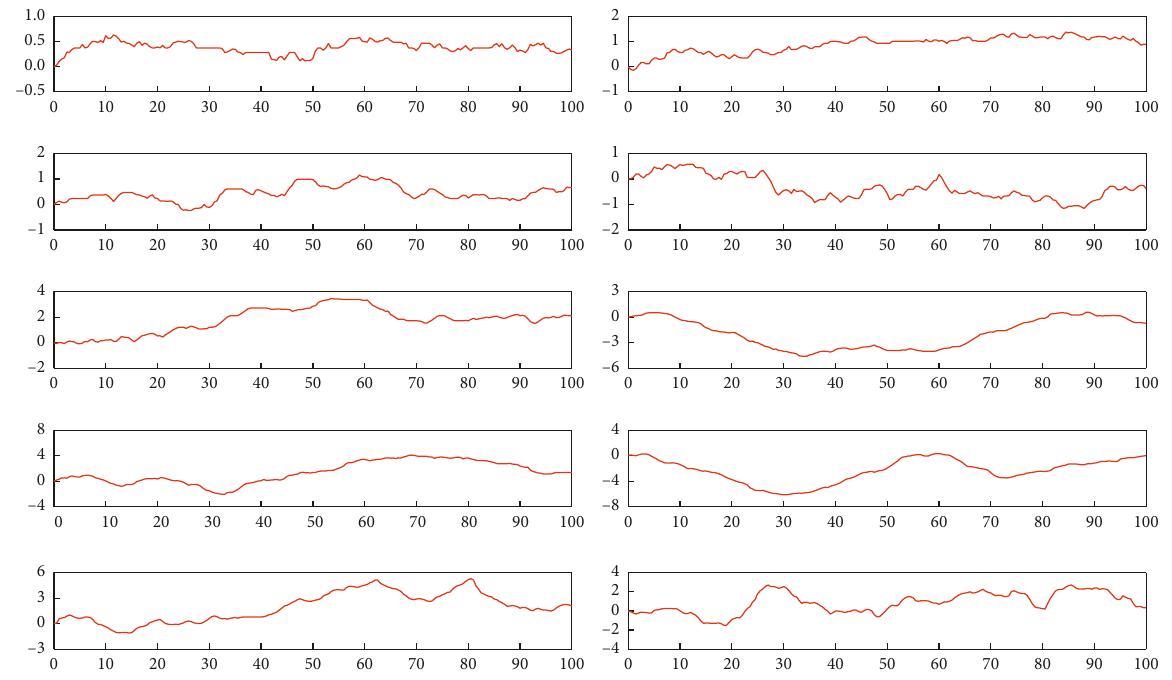
Figure 6: The modified 10 standard roughness profiles (unit: mm). (a) Profile 1. (b) Profile 2. (c) Profile 3. (d) Profile 4. (e) Profile 5. (f) Profile 6. (g) Profile 7. (h) Profile 8. (i) Profile 9. (j) Profile 10.